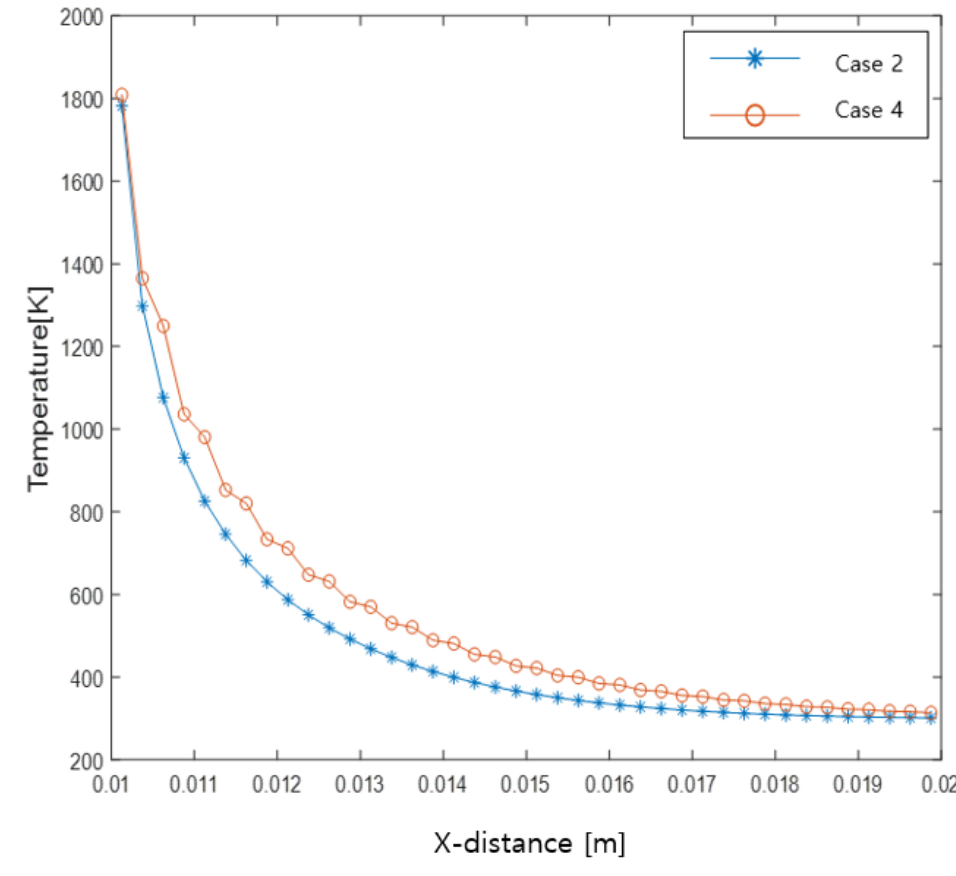
Figure 14. Comparison of simulation temperature for each position along x-direction for case 2 and case 4.